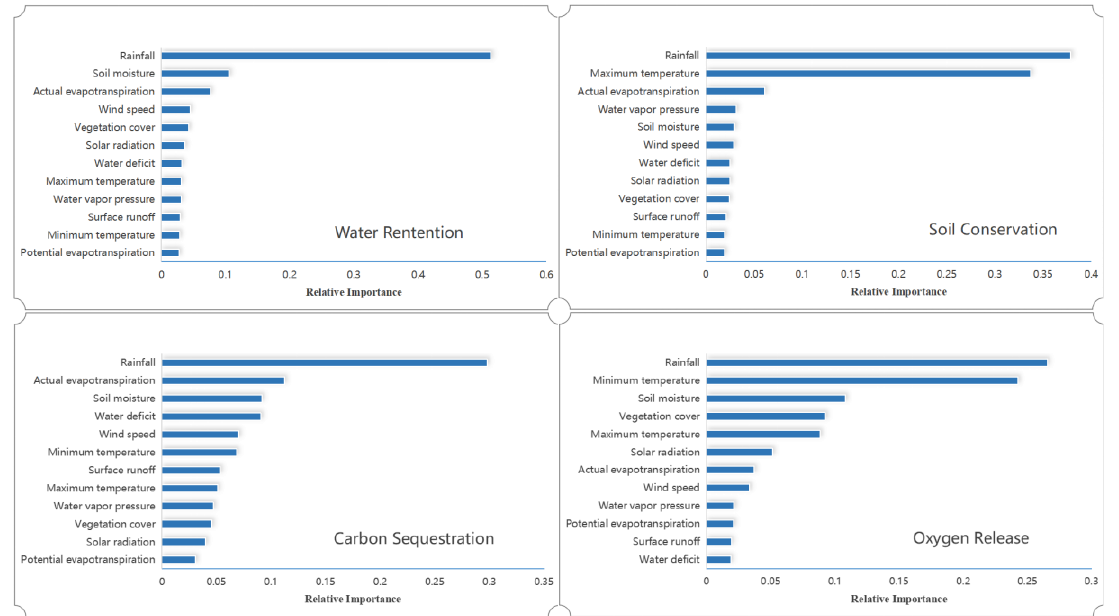
Figure 10. Relative importance ranking of natural factors for the spatial distribution of ecosystem services on Hainan Island.